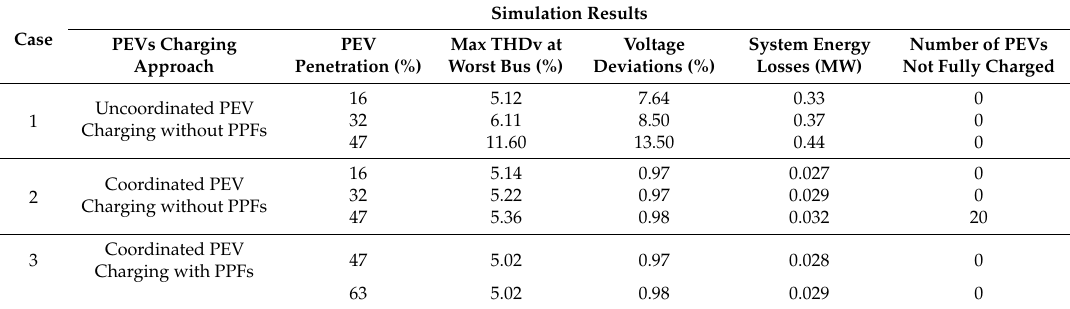
Table 2. Simulated case studies of uncoordinated and coordinated PEV charging (based on a nonlinear online maximum sensitivity selection-based charging algorithm (NOL-MSSCA) considering harmonics without/with passive power filters